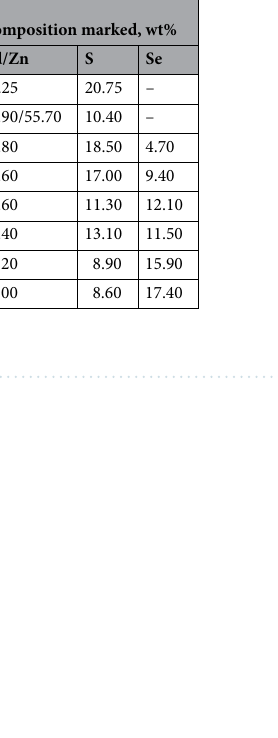
Table 3. Values of specific surface of cadmium pigments, determined by means of methylene blue and acidic orange II.